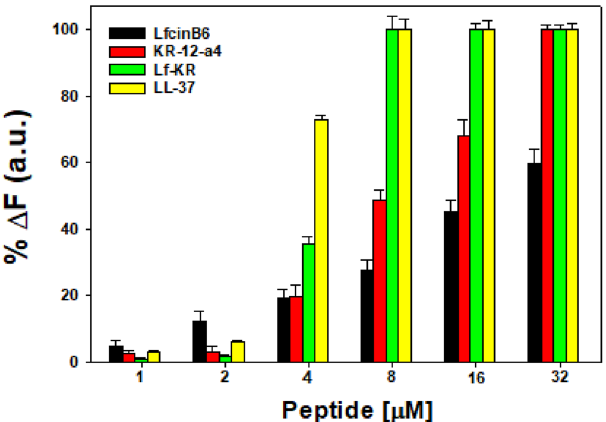
Figure 7. The binding ability of LfcinB6, KR-12-a5, Lf-KR, and LL ‐ 37 to LPS from E. coli 0111:B4. The fluorescence intensity was monitored at an excitation wavelength of 580 nm and an emission wavelength of 620 nm.